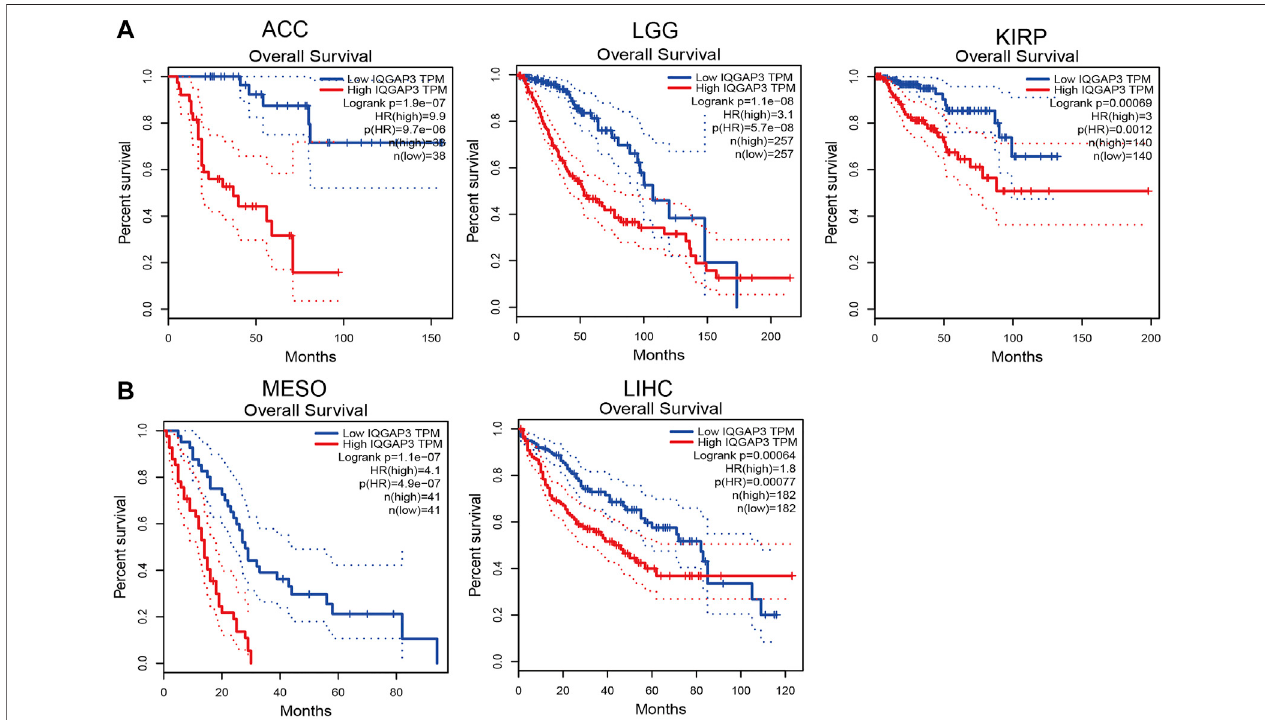
FIGURE3| AnalysisoftheOverallsurvivalforIQGAP3inhumancancers. (A) TheoverallsurvivalforIQGAP3inadrenocorticalcarcinoma,brainlowergradeglioma, and kidney renal clear cell carcinoma analysis by using the GEPIA database, and (B) the overall survival for IQGAP3 in mesothelioma and liver hepatocellular carcinoma analysis by using the GEPIA